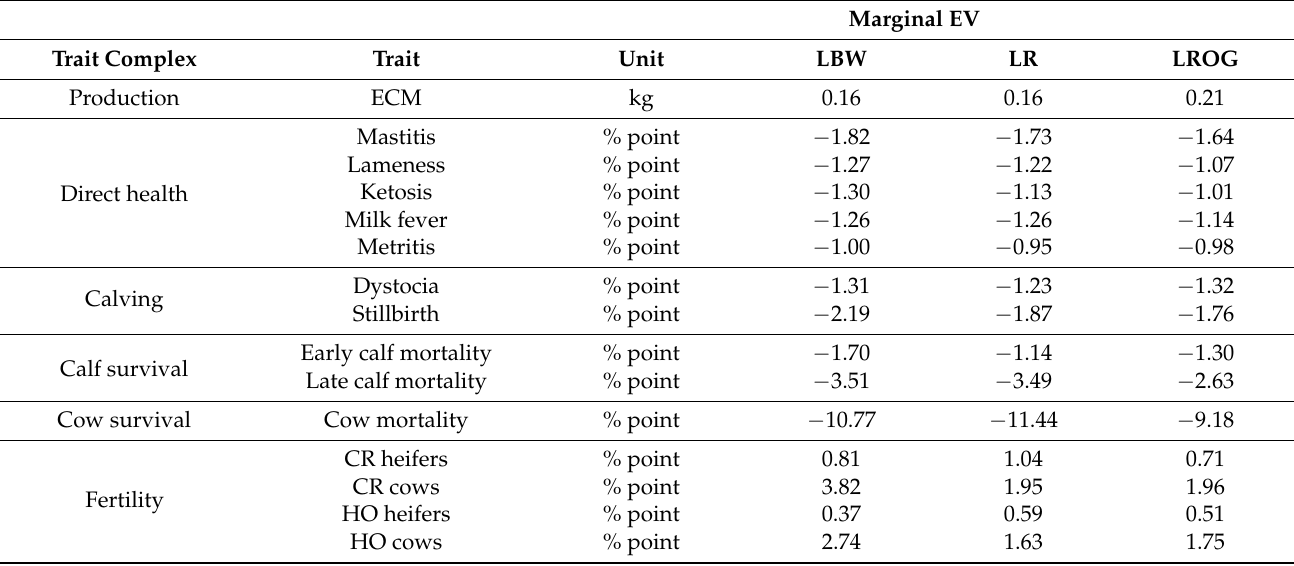
Table 8. Marginal economic values (in Euro per change in trait unit and